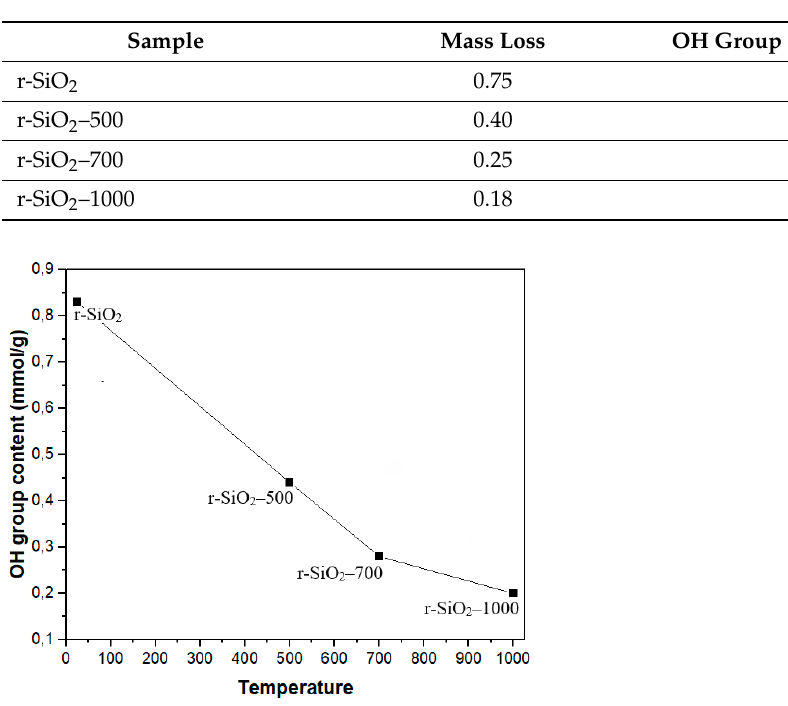
Figure 9. TGA spectra of the SiO 2 aggregate without heat treatment and heated at 500 °C, 700 °C, and 1000 °C.